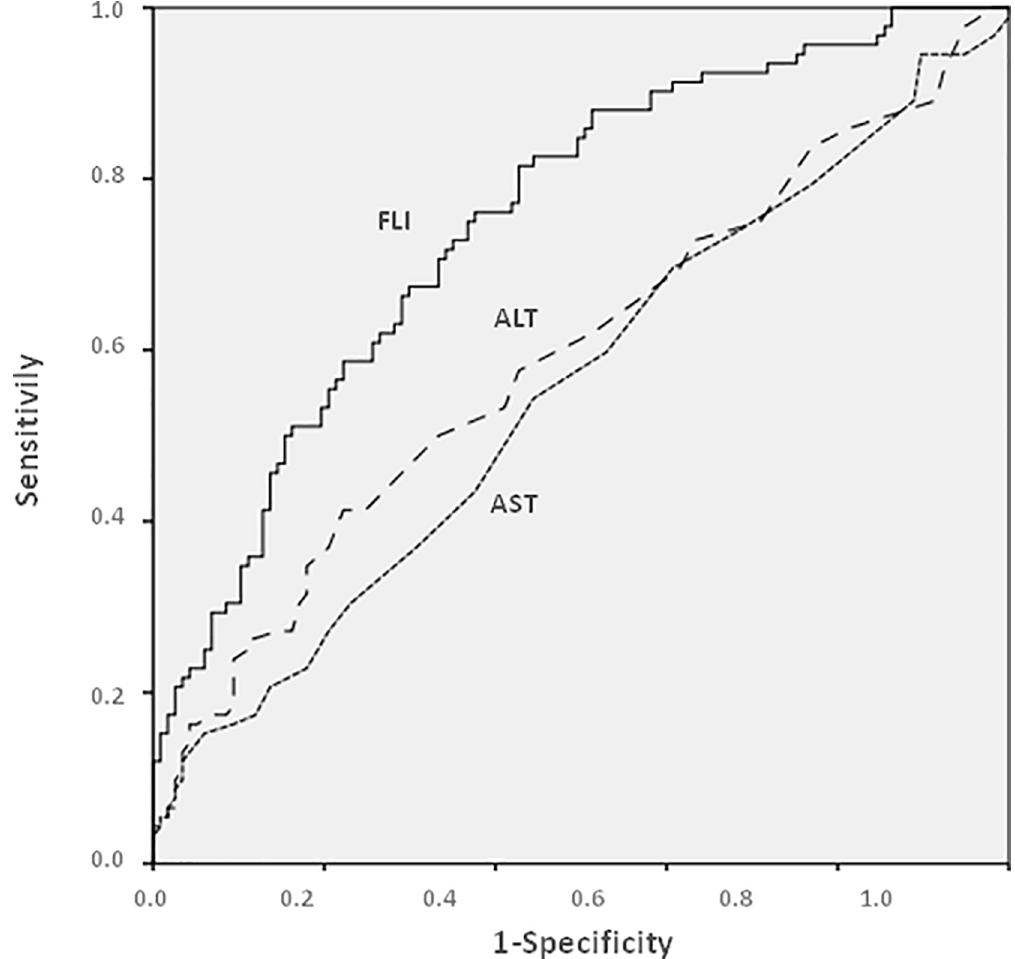
Fig 3. Predictive accuracy of FLI, AST and ALT, as assessed by AUROC curves, in the diagnosis of severe steatosis in the group of patients with metabolic risk factors of NAFLD.